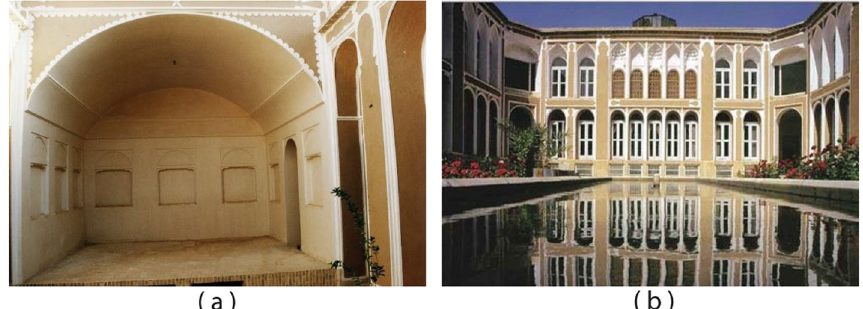
Fig. 12 Openings in Yazd adobe houses: ( a ) main walls of the Zargar house (Source: Haji‑Qassemi and Khoei 2004) and ( b ) gable walls of the Mortaz house (Source: the authors)